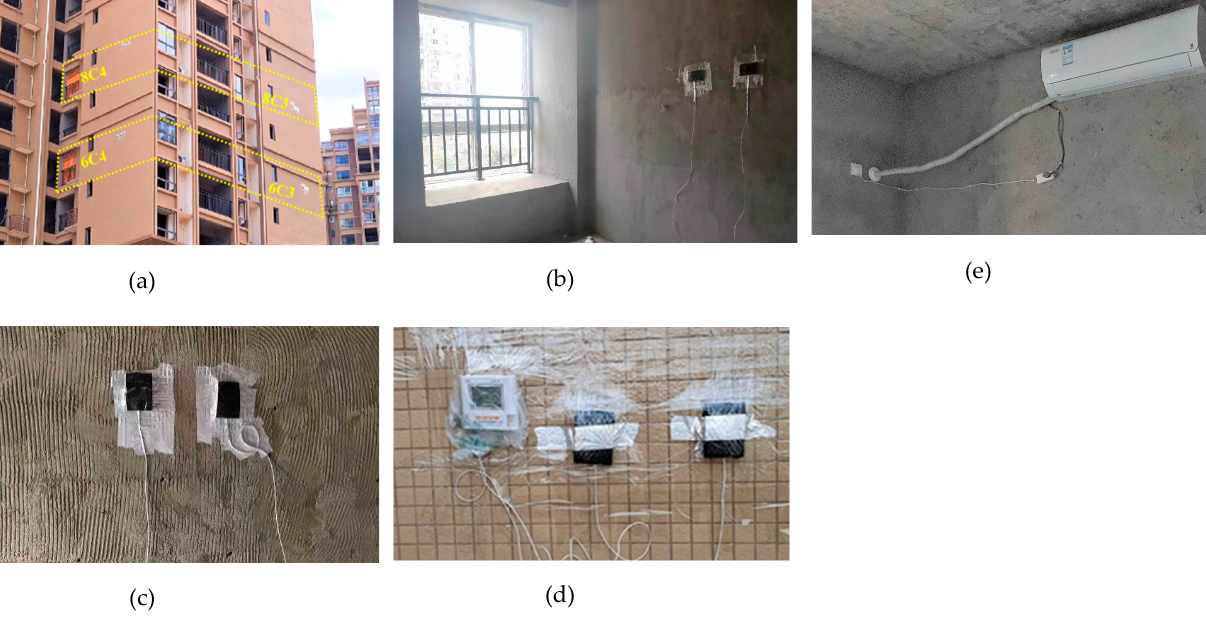
Figure 4. Photos of ( a ) exterior view of the tested rooms; ( b ) interior view of the tested rooms; ( c ) sensors mounted on the inside wall; ( d ) sensors mounted on the outside wall; ( e ) split air conditioner.